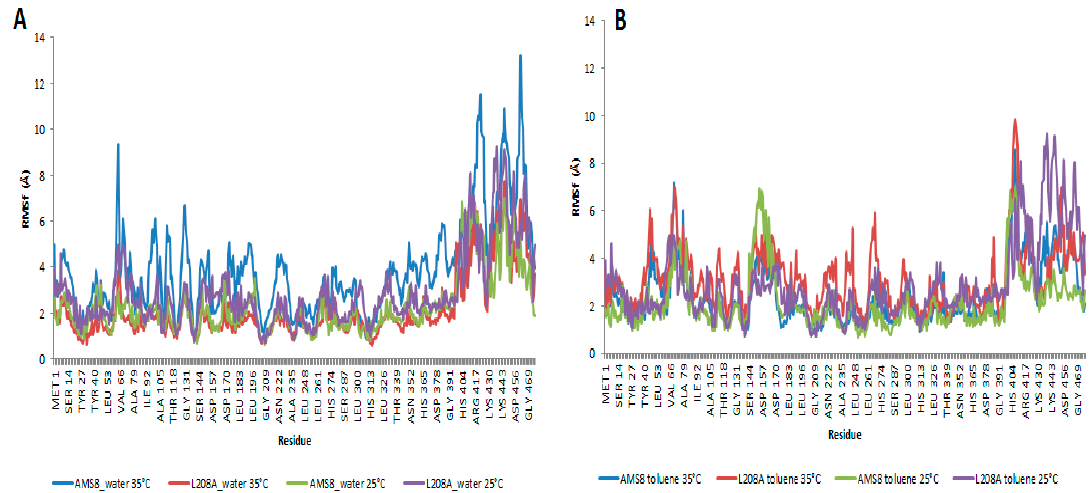
Figure 4. The root-mean-square (RMSf) distance between the C α atoms in the simulations and the protein structure of AMS8 and its mutant L208A in water—( A ) and toluene—( B ) at 25 °C and 35 °C respectively.